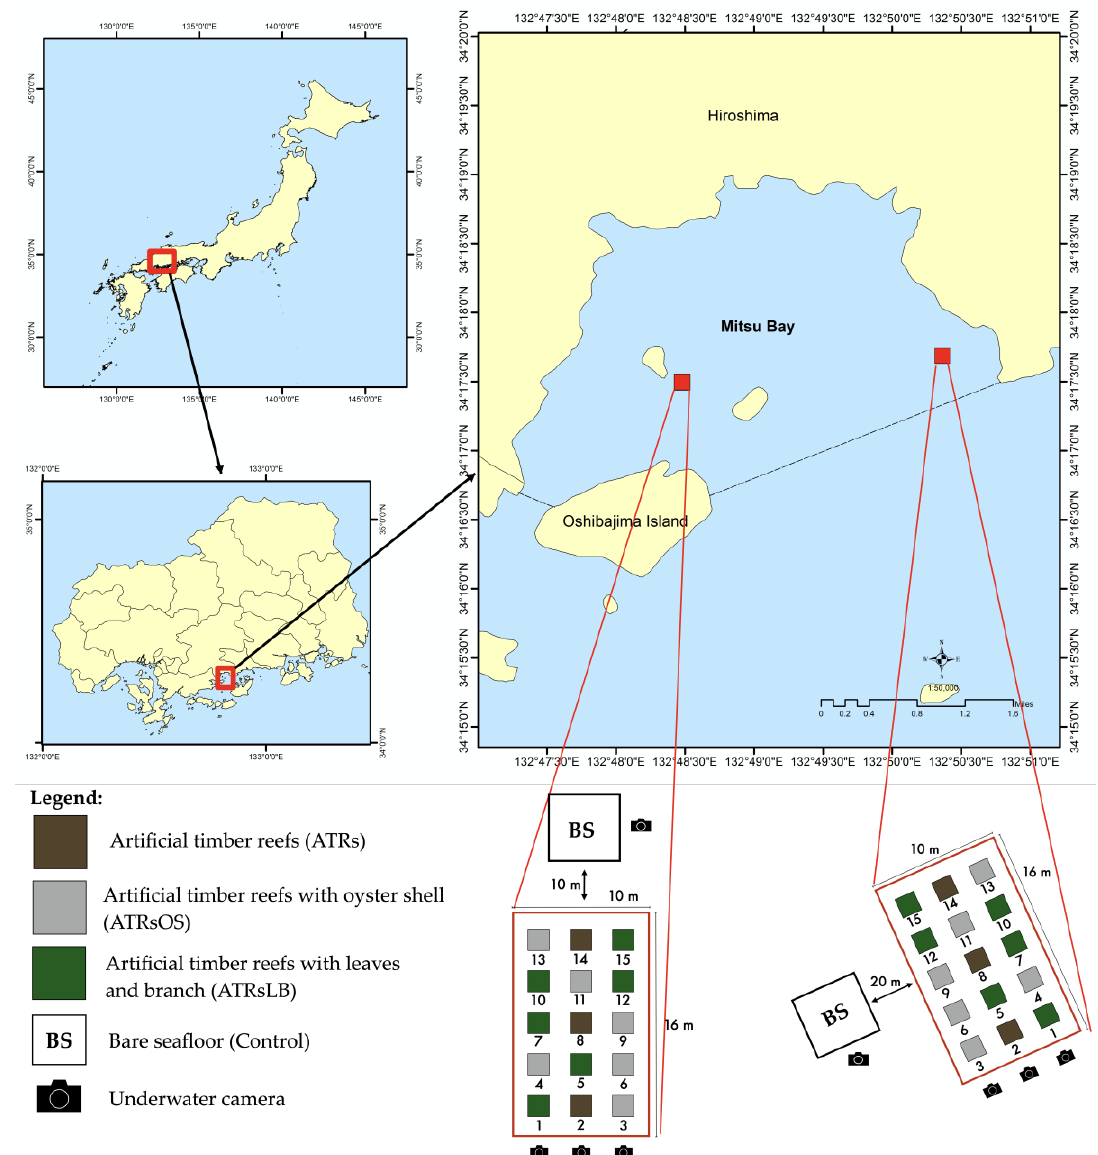
Figure 1. Experimental design and the locations of artificial timber reefs deployed in Mitsu Bay, Hiroshima Prefecture, Japan .